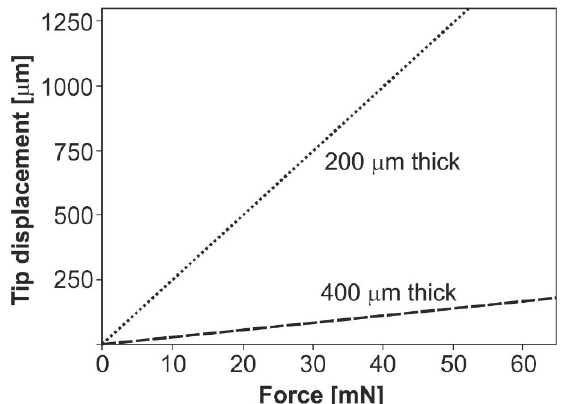
Figure 4. Examples of force vs. tip displacement of the measured 200 µ m thick and 400 µ m thick microbeams.